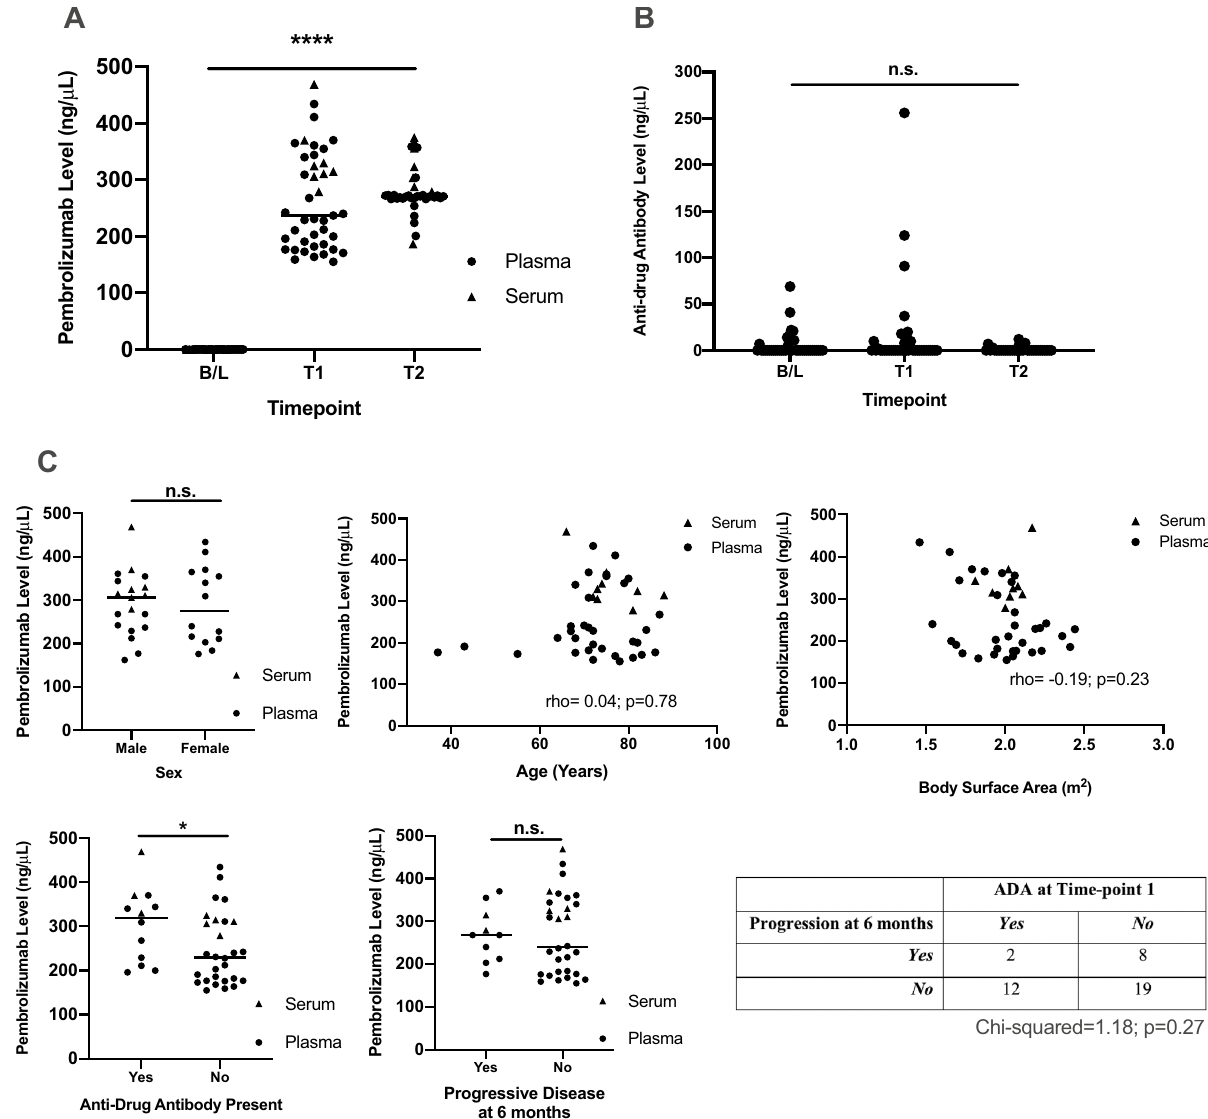
Figure 2. Pembrolizumab drug and anti-drug antibody (ADA) levels in a clinical cohort . Data generated from patients with melanoma treated with pembrolizumab (n=41). ( A ) Pembrolizumab drug level at baseline (B/L), just prior to Cycle 2 (T1) and last available timepoint (T2; Median Cycle 7 or 21 weeks IQR Cycle 4-13). ( B ) pembrolizumab ADA were detectable at B/L, T1 and T2. ( C ) Clinical correlates to pembrolizumab drug level just prior to Cycle 2 (T1). Pembrolizumab drug level did not significantly correlate with sex, age, body surface area or progressive disease at 6 months. Patients with an ADA at T1 had higher pembrolizumab drug levels